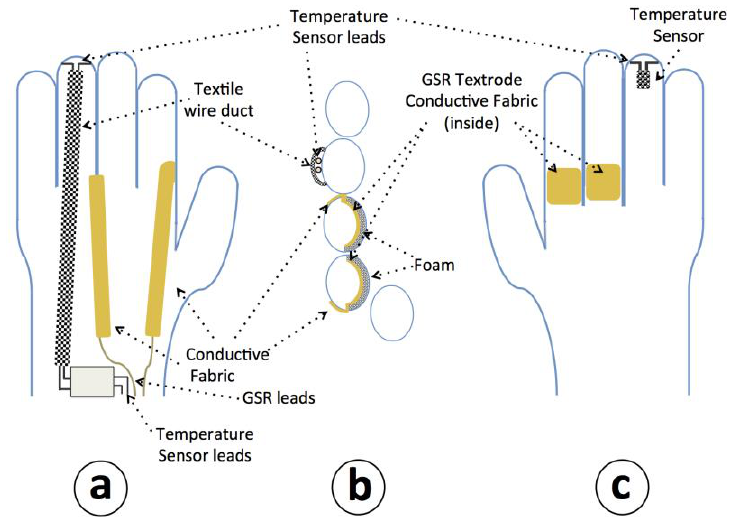
Figure 4. Drawing of the sensorized glove. ( a ) Upper view of the glove. ( b ) Cross-sectional view of the glove at the proximal phalanx in a perpendicular plane to the palm. ( c ) Palm view.